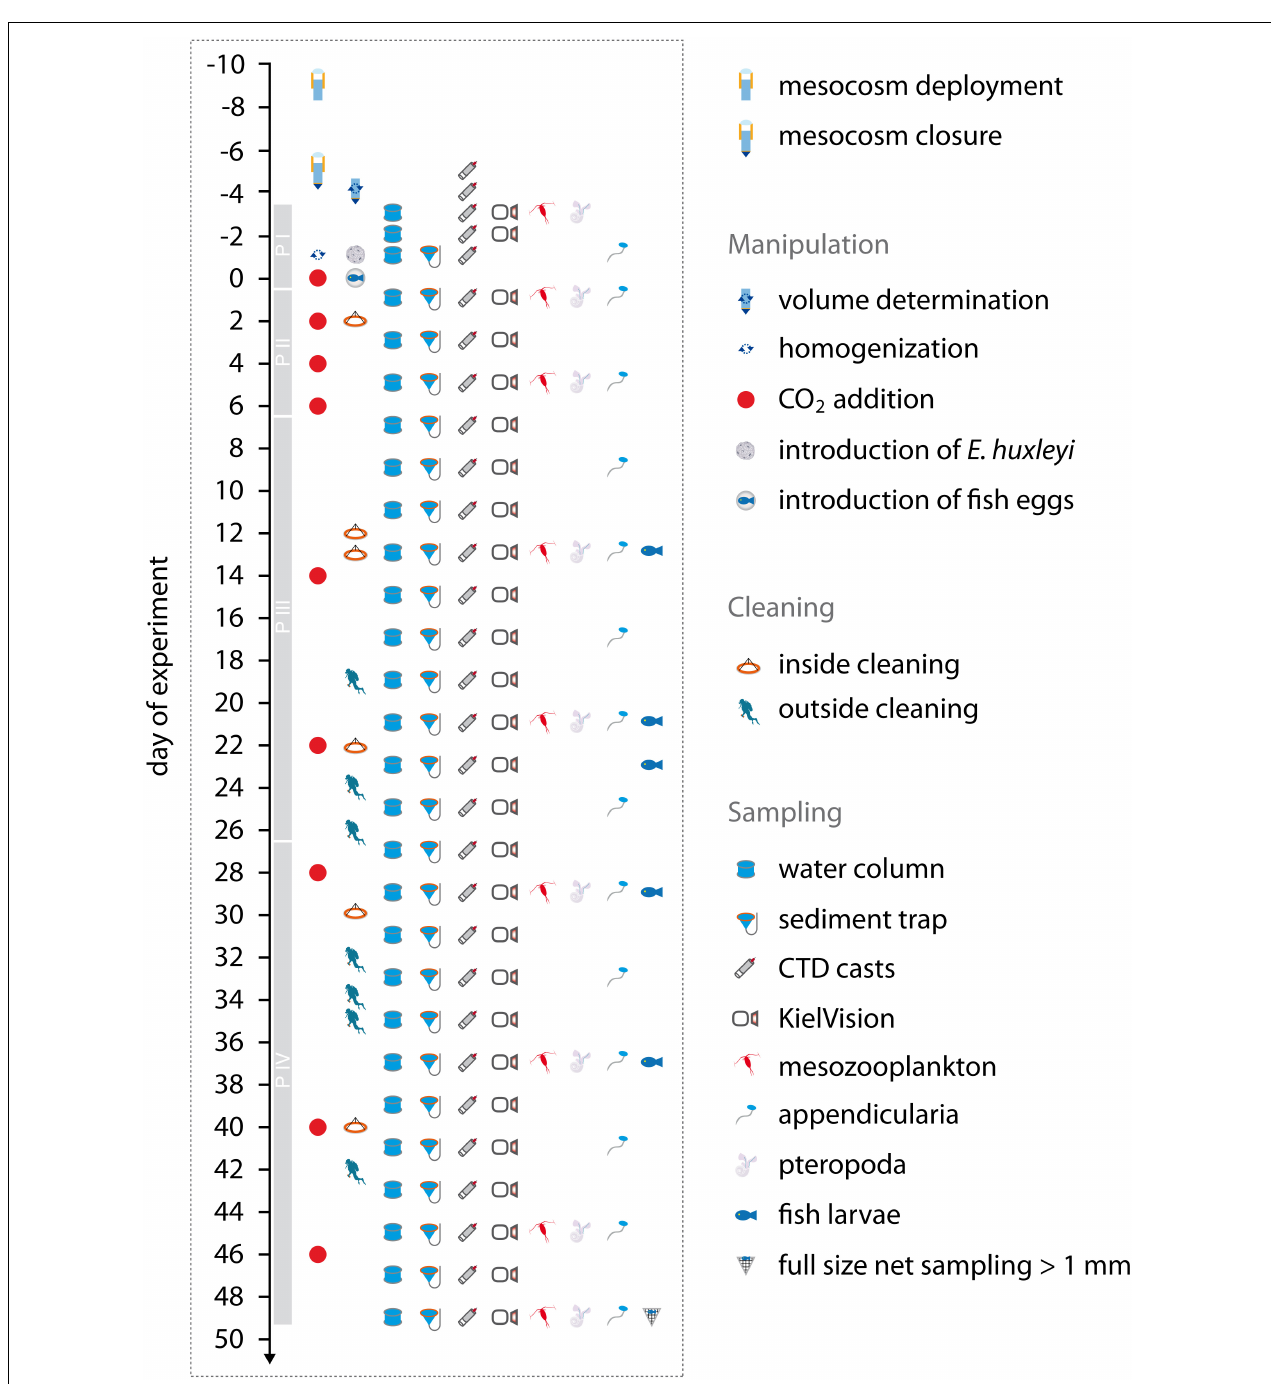
FIGURE 2 | Overview of all sampling and maintenance activities over the course of the experiment, as described in detail in section “Volume Determination”, section “CO 2 Addition”, section “Addition of Organisms to the Mesocosms”, section “Cleaning of Mesocosm Surfaces”, and section “General Sampling Procedure”. Gray bars on the timeline represent the individual phases of the experiment as explained in Table 2 . Figure assembled and designed with Adobe Illustrator CS4 (Adobe-Inc,